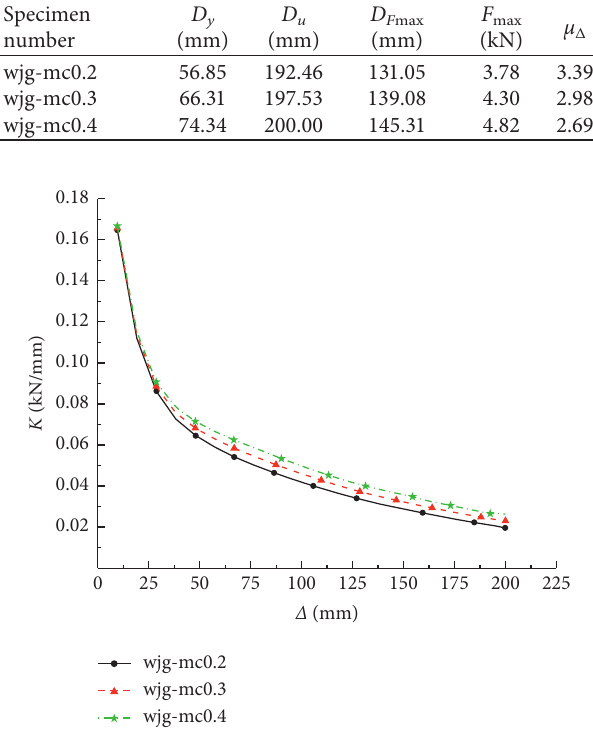
Figure 24: Stiffness degradation curves of group C models.